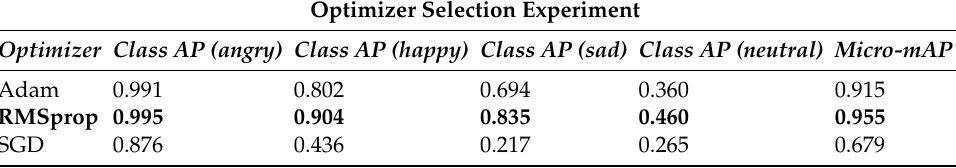
Table 2. Performance of the proposed bi-modular sequential neural network with different optimiza- tion